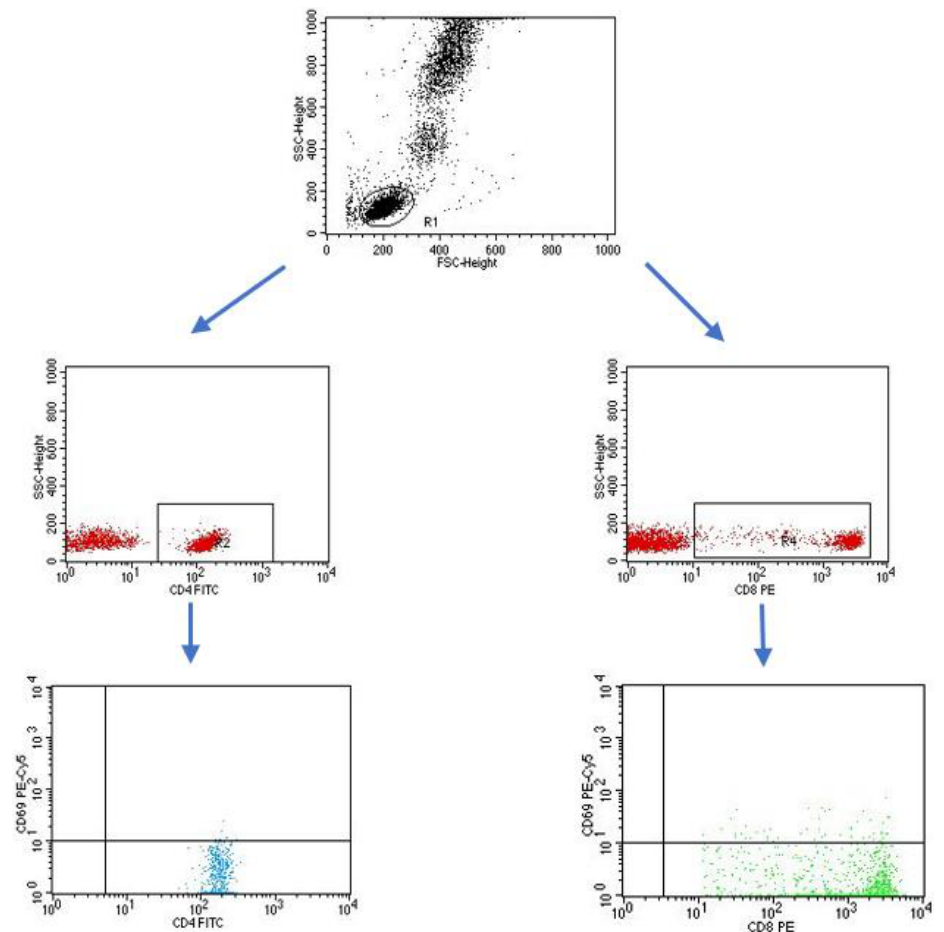
Figure 9. Sample analysis of the percentage of T cells with the CD4+CD69+ and CD8+CD69+ pheno- type.